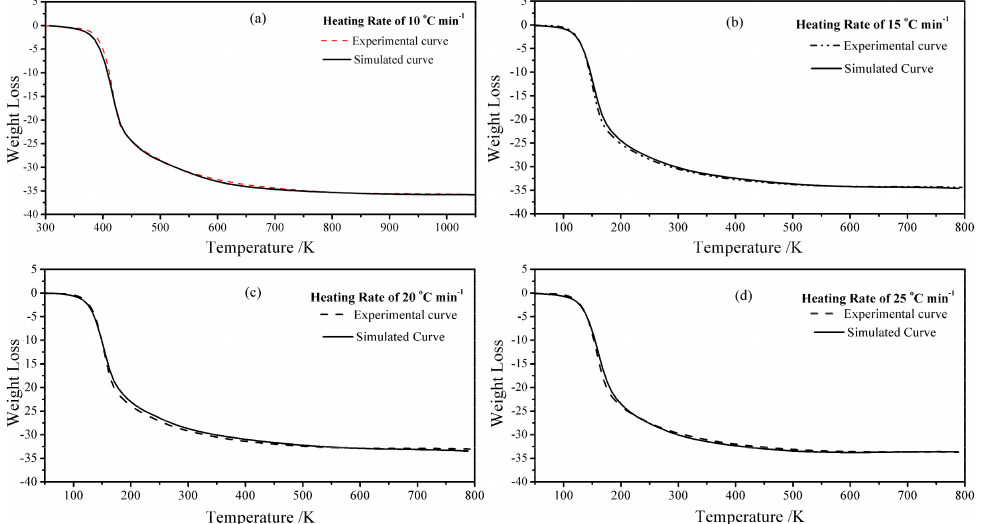
Figure 6. The comparison between the weight loss from experimental and simulated by deconvolu- tion curves fitting method at four heating